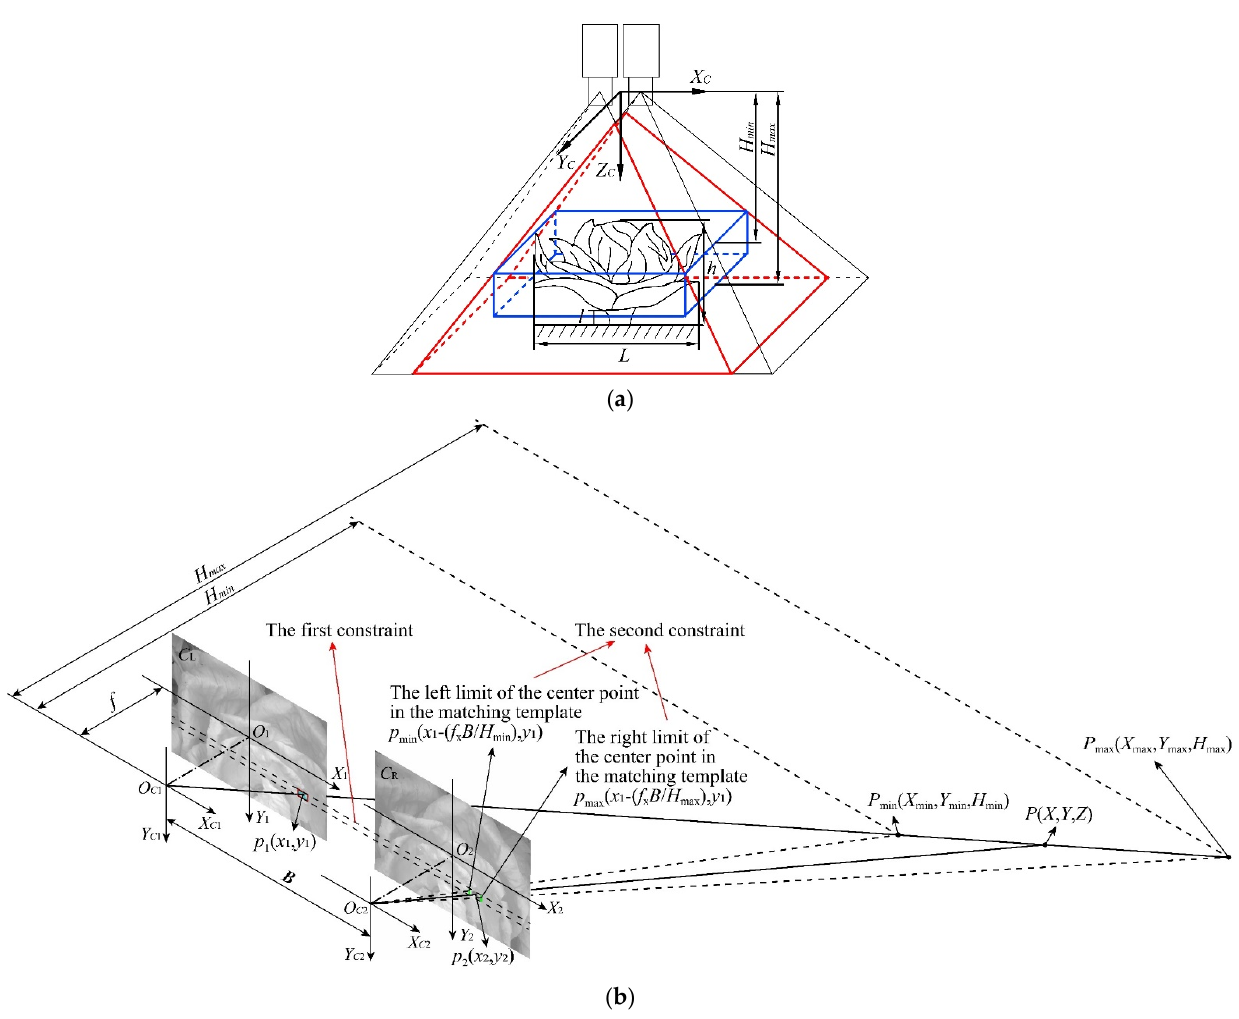
Figure 12. Search range of the multi-constraint stereo matching method. ( a ) The binocular vision locating system. The red frame is the binocular public area, the blue frame is the operation area for locating pests, and the depth range is H min ∼ H max . L is the leaf spreading degree; h is the plant height; and l is the bottom leaf height of the cabbage. f x is the camera fixed parameter. ( b ) The spatial geometric diagram. O C 1 and O C 2 are the optical centers of the cameras on the left and right, C L and C R are the imaging planes of the binocular cameras, and the image coordinate systems are X 1 O 1 Y 1 and X 2 O 2 Y 2 , respectively. p 1 ( x 1 , y 1 ) is the laser strike point in the image on the left; p 2 ( x 2 , y 2 ) is the center point of the best matching box in the image on the right; P ( X , Y , Z ) are the target